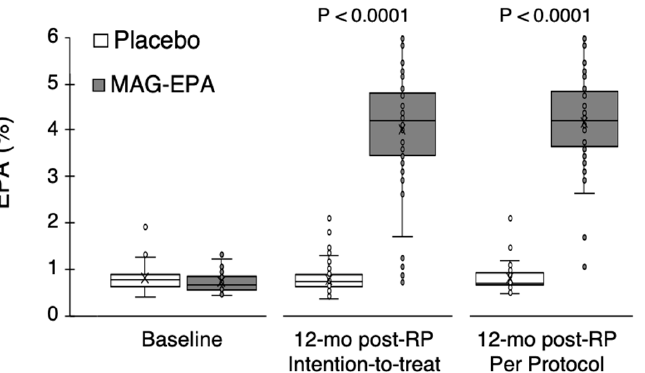
Figure 2. EPA level in red blood cell membranes of patients. EPA level is expressed as a relative percentage of total fatty acids, at the study baseline (n = 130) and after one year following RP, for the intention to treat population (n = 116) and the per-protocol population (n = 87 patients who took at least 80% of capsules). p -values were obtained using the Wilconxon test. RP: radical prostatec-